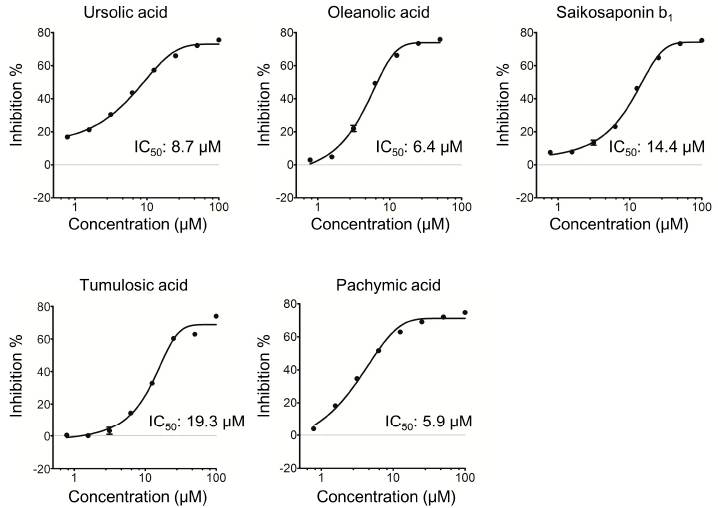
Figure 2. Dose-dependent anti-KLK5 activity of triterpenoids. All samples were evaluated at the described concentrations. The percentage of inhibition was calculated based on the formula: (1 − (A − B)/(C − B)) × 100, where A, test sample RFU; B, basal RFU without KLK5; and C, vehicle RFU. Data are presented as mean ± SEM of triplicate tests.